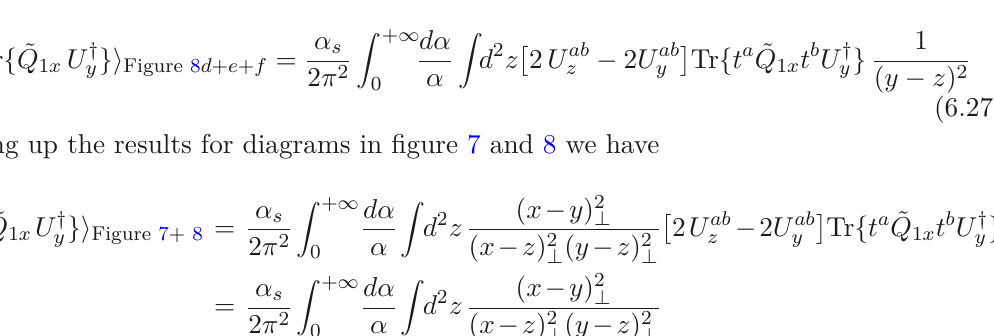
Figure 8 . Self-energy diagrams with sub-eikonal correction inside and outside shock-wave.